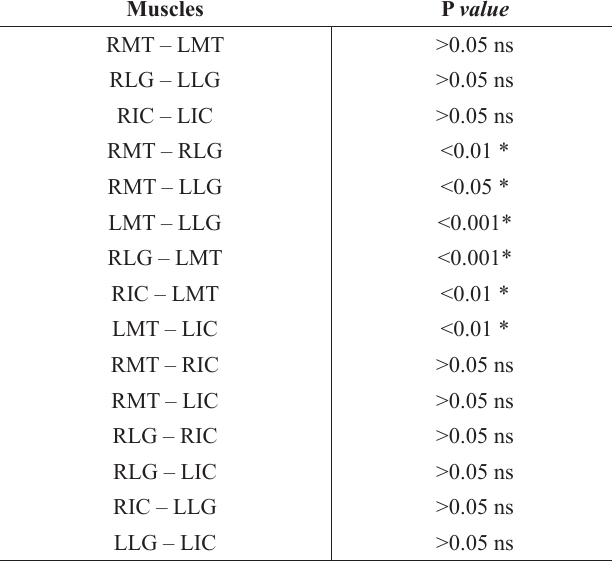
3. Comparative analysis between the multifidus muscle (MT), lumbar longissimus (LG) and iliocostalis (IC) on the right side (R) and left (L) of 20 volunteers, for values of slope coefficient of MF ( n = 60) obtained during the Sorensen